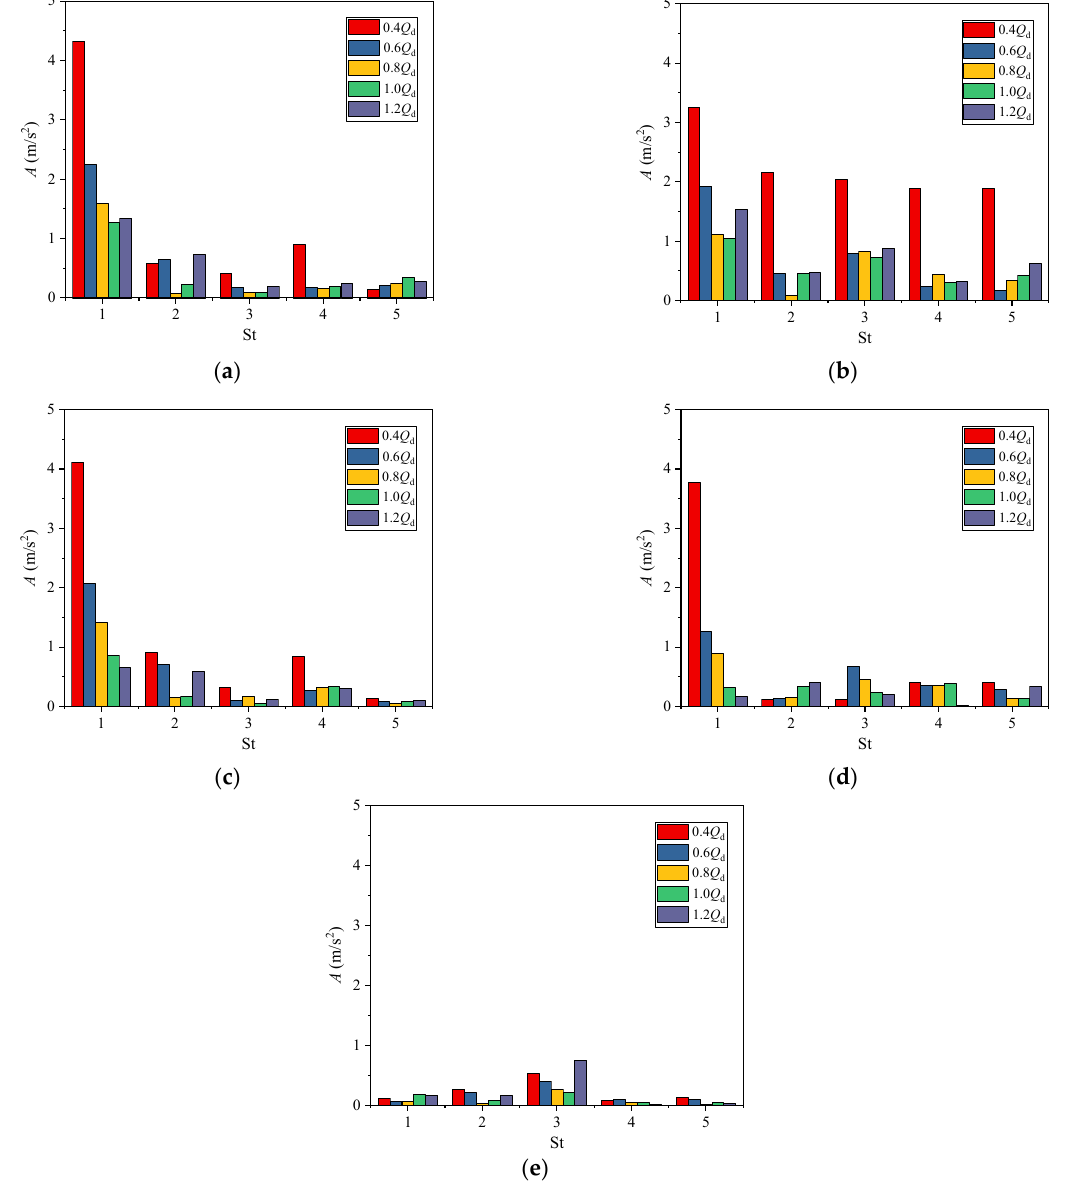
Figure 17. Vibration amplitude of different measuring points at different flow rates: ( a ) No. 1 measuring point; ( b ) No. 2 measuring point; ( c ) No. 3 measuring point; ( d ) No. 4 measuring point; ( e ) No. 5 measuring point.